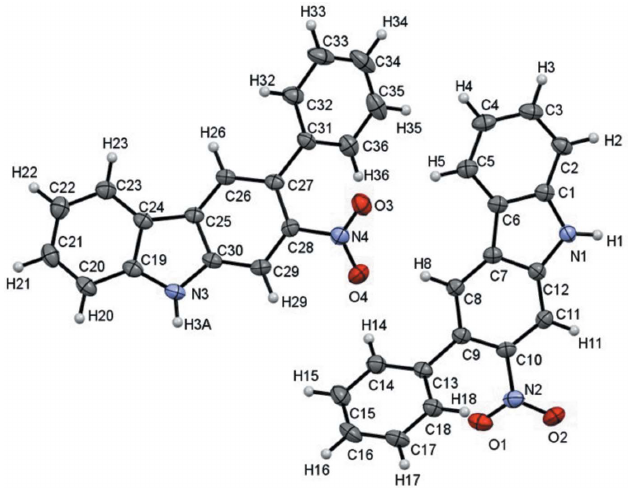
Figure 1 The asymmetric unit of the title compound, with atom labelling and displacement ellipsoids drawn at the 50% probability